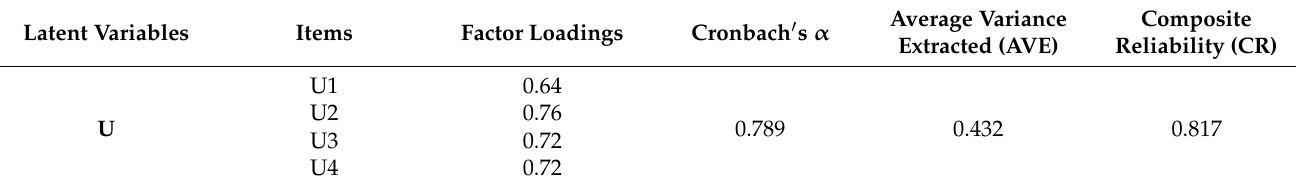
Table 5. Tests of reliability and